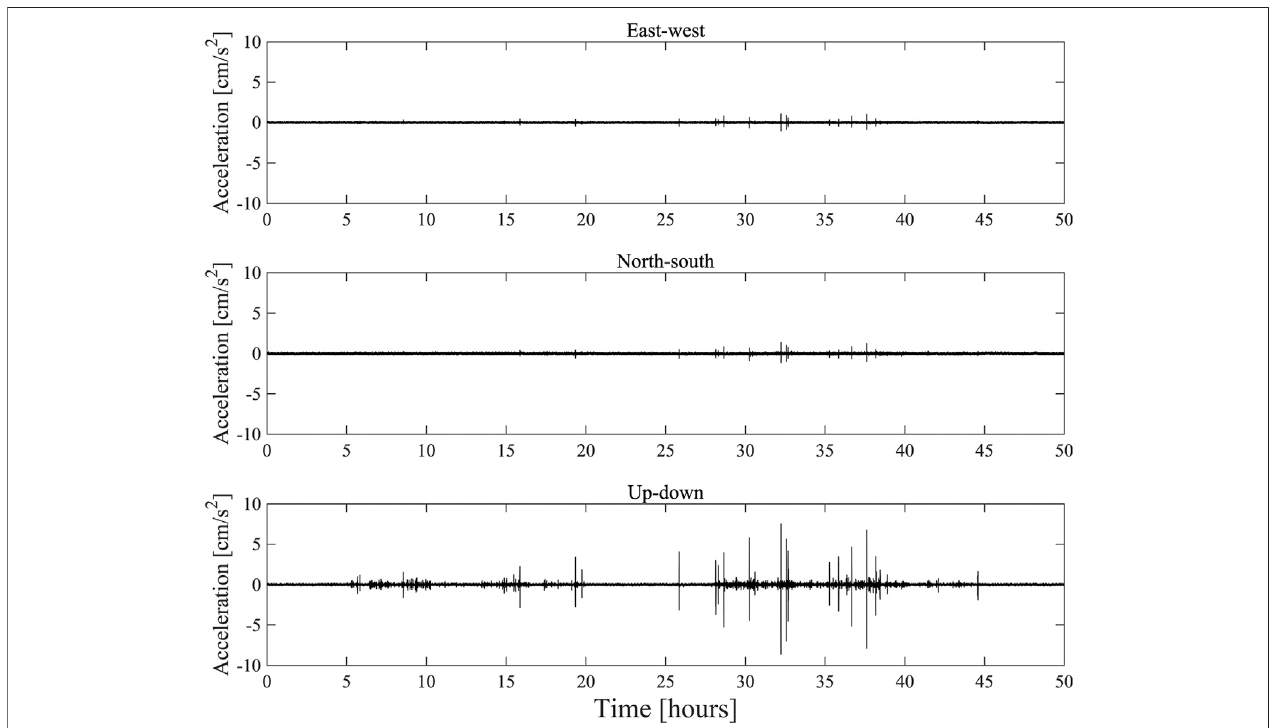
FIGURE3| Three-componentnoisetimeseriesrecordedatalow-costintensitysensor(23.67 o N,116.64 o E).TherecordsstartonFebruary19,2019,andare50 h long. The noise is largest on the vertical component, likely due to human activities. See Supplementary Figure S1 for frequency domain